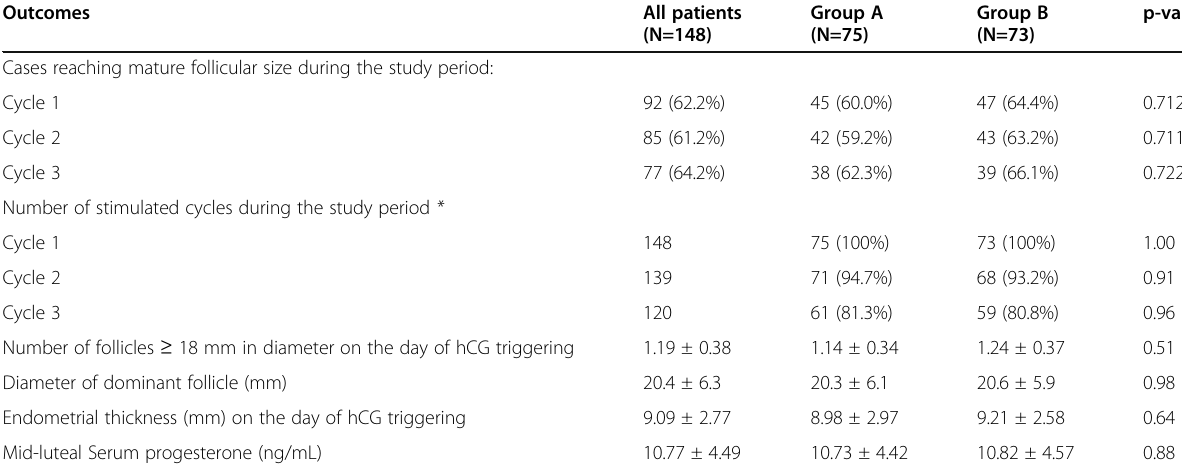
Table 2 The primary